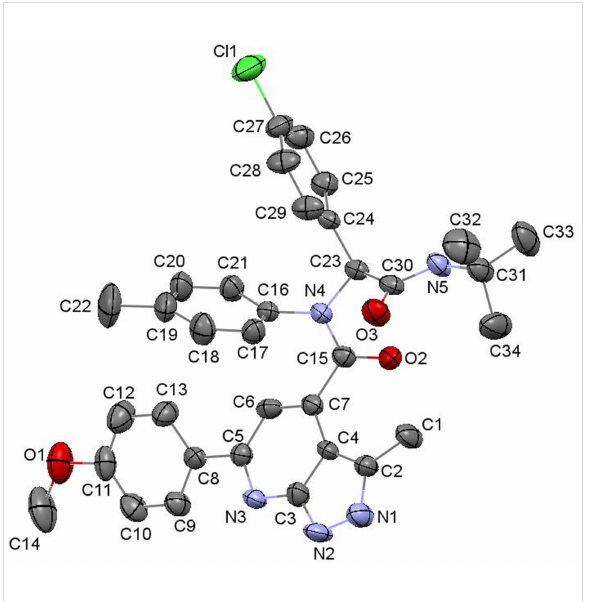
Figure 1: Molecular structure of N -(2-( tert -butylamino)-1-(4-chloro- phenyl)-2-oxoethyl)-6-(4-methoxyphenyl)-3-methyl- N - p -tolyl-1 H -pyra- zolo[3,4- b ]pyridine-4-carboxamide ( 11n ) according to X-ray diffraction data. Non-hydrogen atoms are presented as thermal ellipsoids with 50%